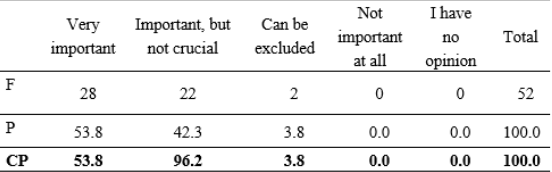
Table 8. Which skills of instrumental performance are advanced in solfeggio teach- ing?